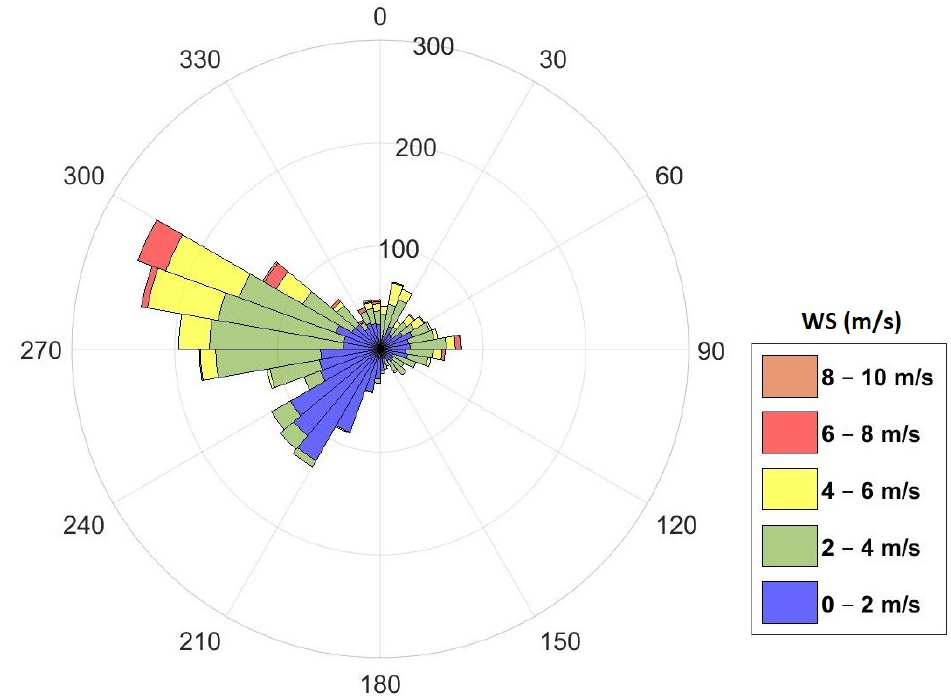
Figure A2. The wind rose of the area for 2020 from the data of the AURA